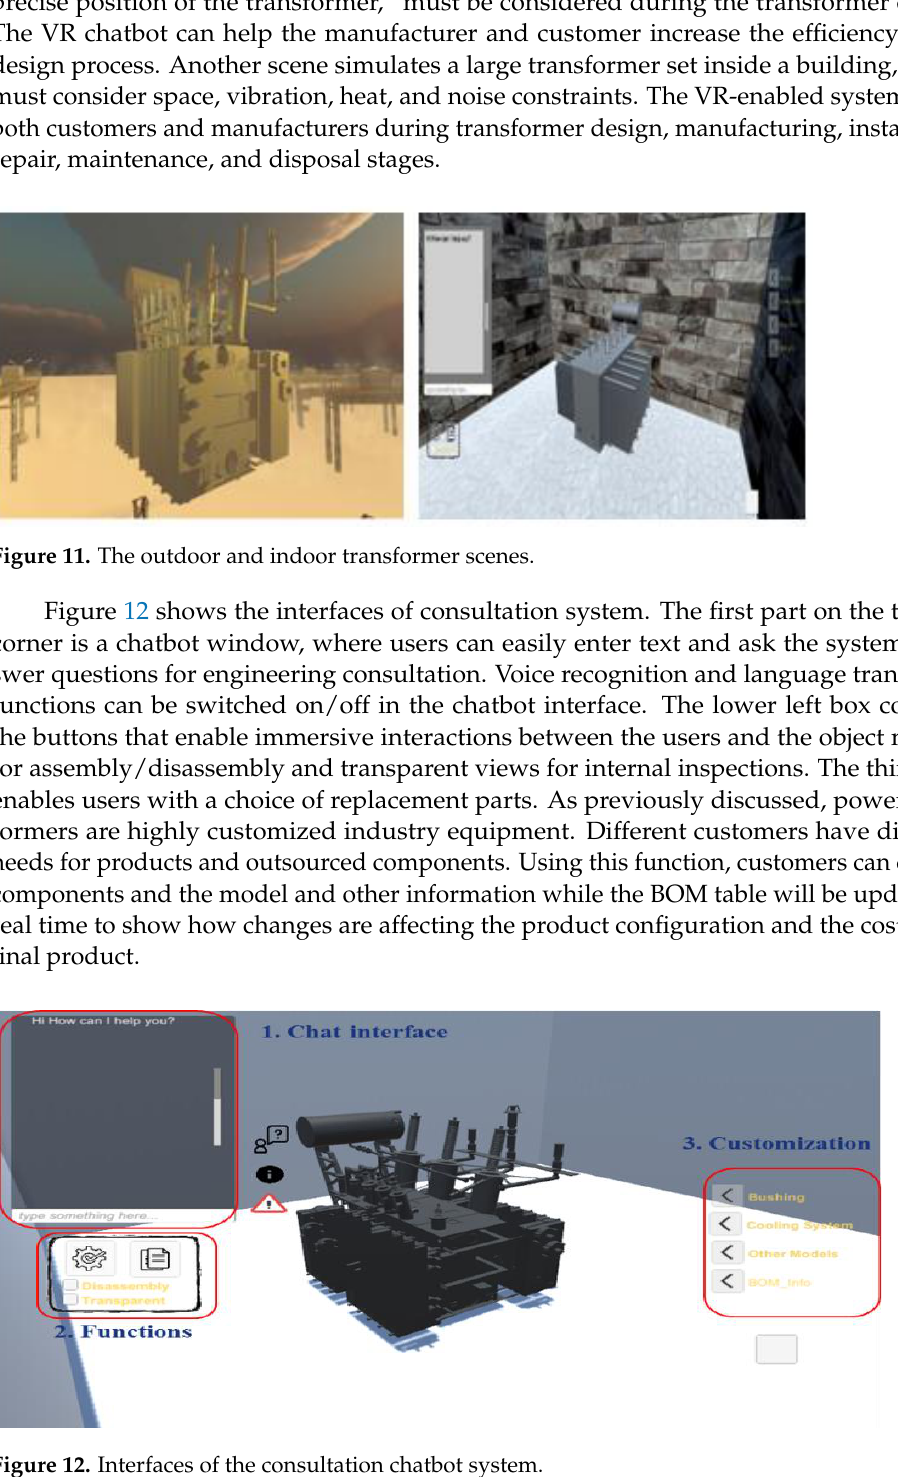
Figure 10. Four power transformers constructed in this research.